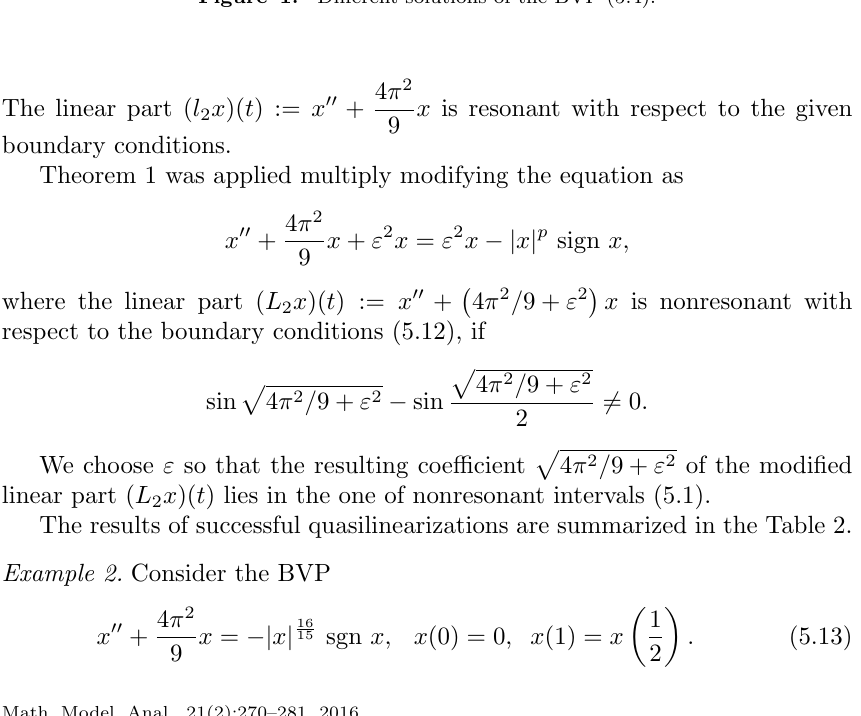
Figure 1. Different solutions of the BVP